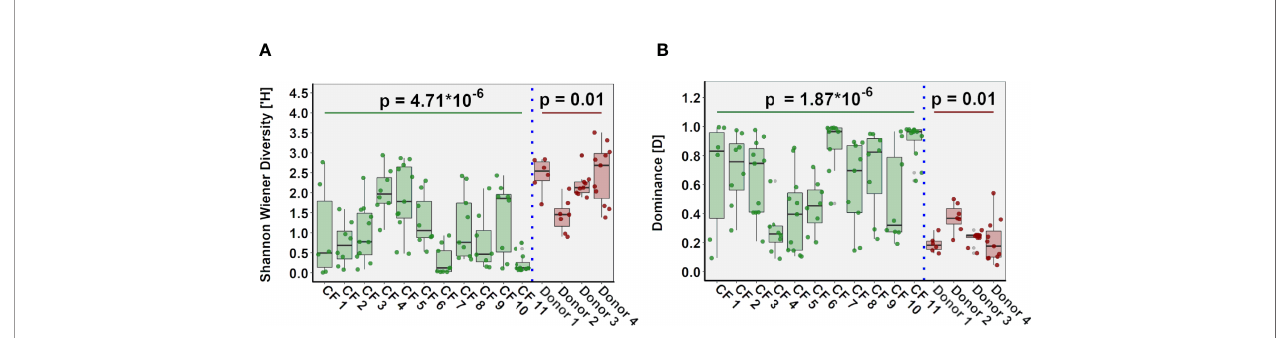
FIGURE 5 | Inter-individual variation in ecological parameters in CF (n=11 patients) and donor (n=4 patients) cohorts. (A) Shannon-Wiener diversity